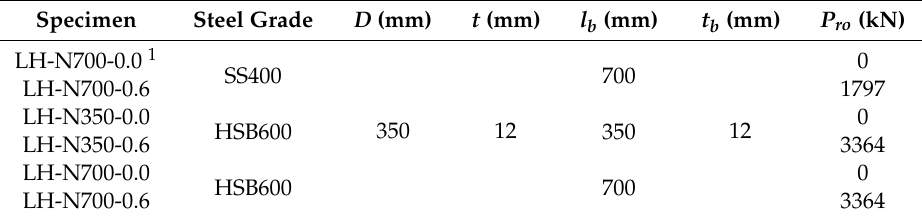
Table 2. Specimens for validating the finite element (FE) model.